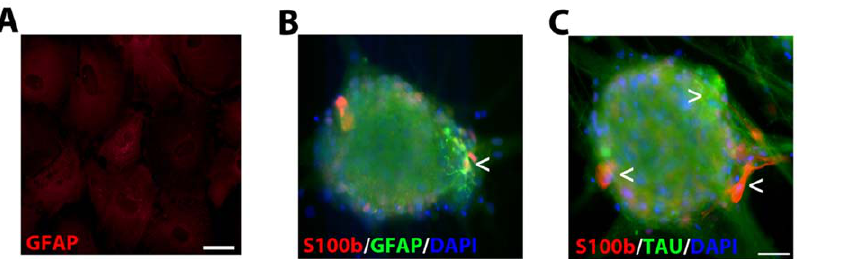
Figure 2. Cell types following all-trans-retinoic acid differentiation of NTera2 cells before purification of neurons. Large protoplasmic astrocytes-like cells that form the basal layer of cells that NTera2 neurons rest on display weak GFAP staining (A). Neural cluster which contains multipolar fibrous astrocytes which co-express GFAP and S-100 b (B). The fibrous astrocytes do not display co-expression of S-100 b with b -tubulin III positive neurons (C). Photomicrographs were obtained at 100X (A; scale bar 200 m m) and 400X (B–C; scale bar 50 m m).